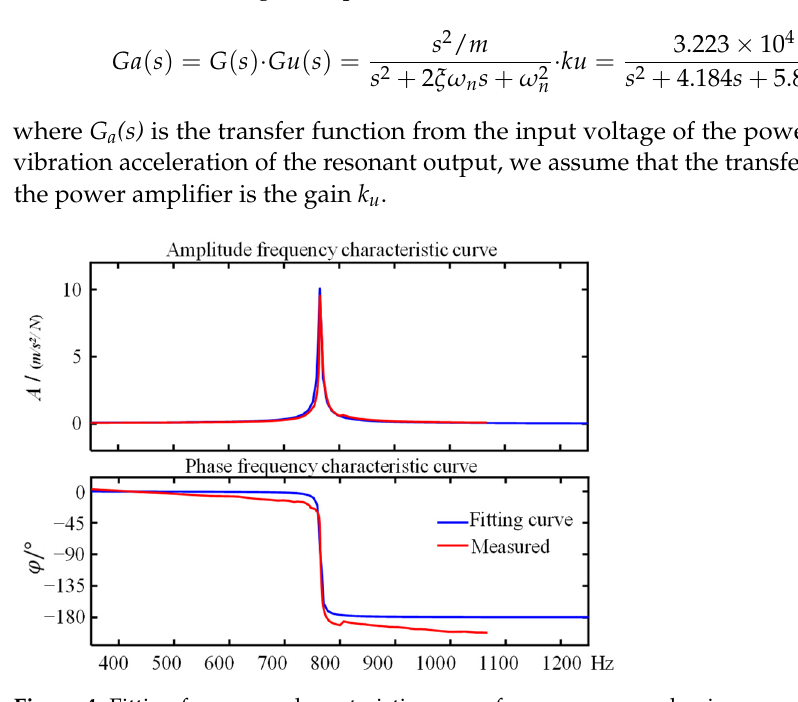
Figure 3. Simplified model of the resonant beam.